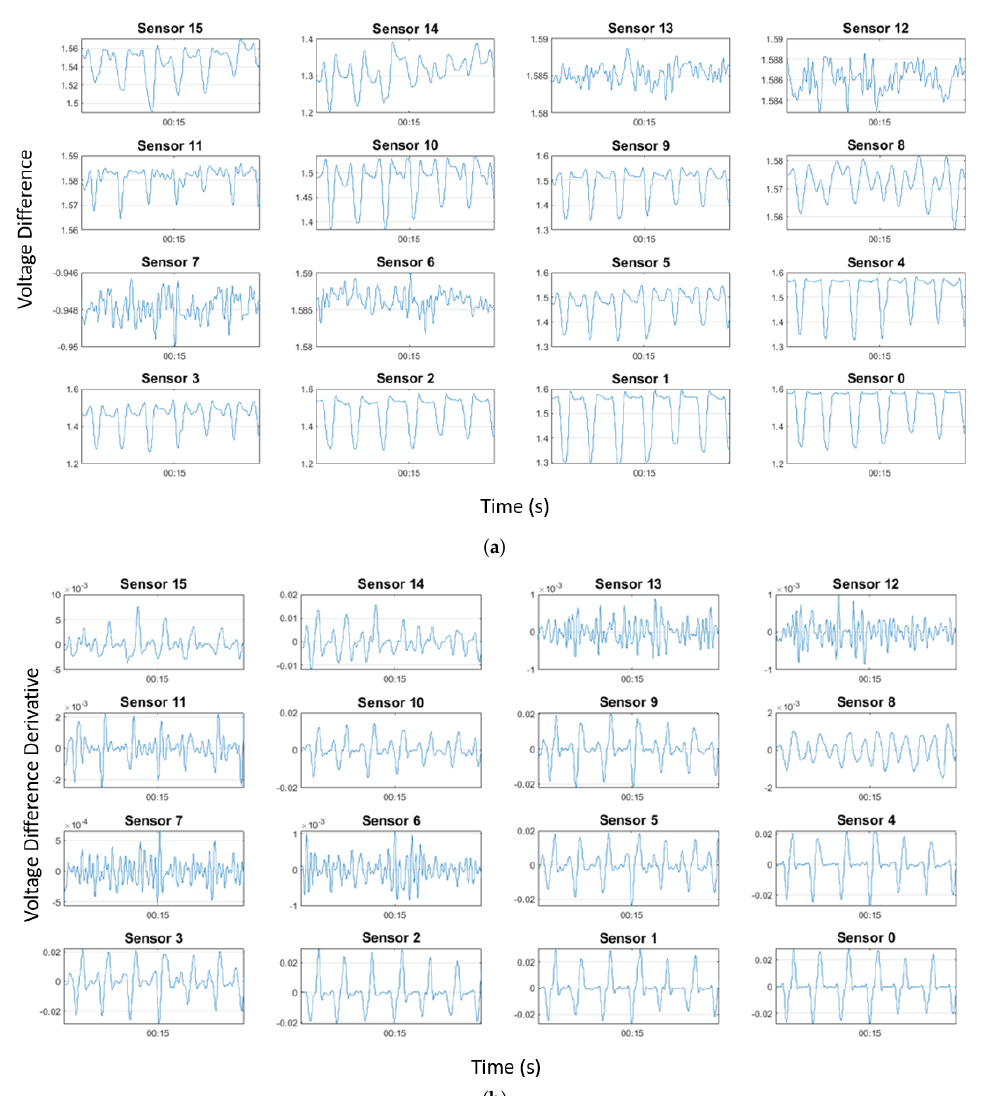
Figure 6. Representative sensor data and its derivative from 30 s of open chain knee